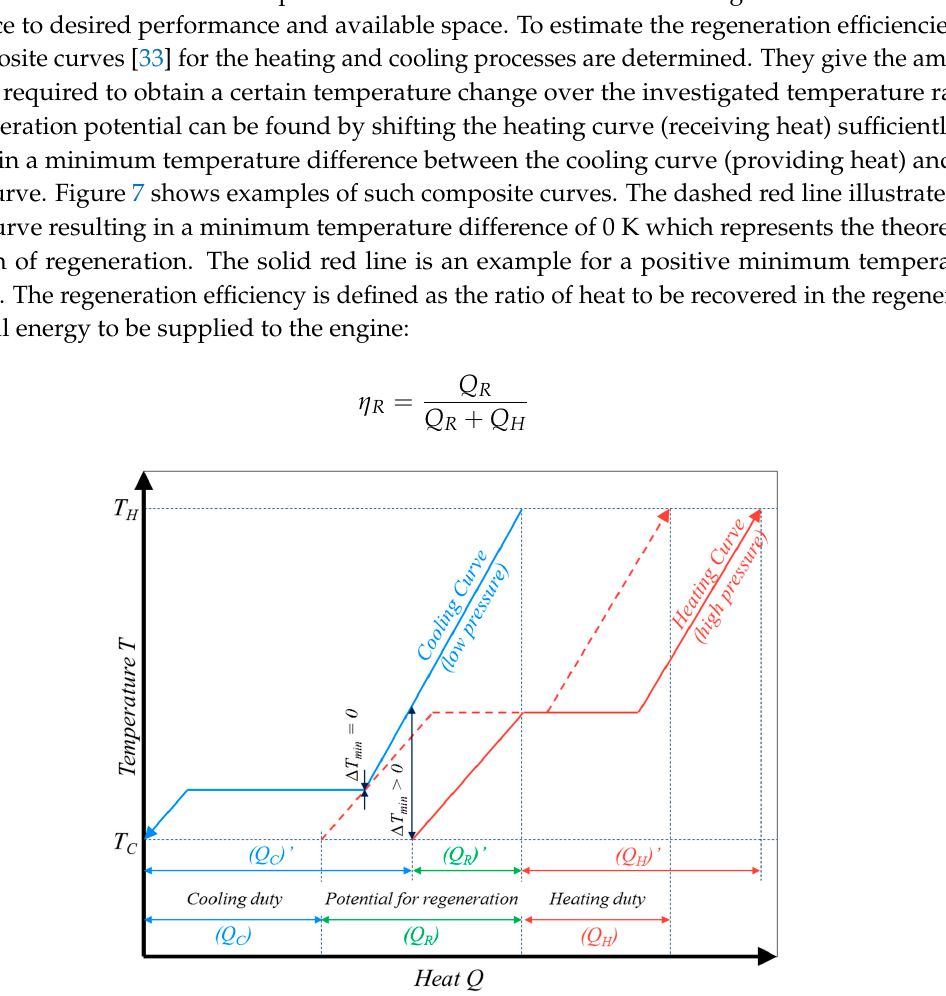
Figure 7. Example of composite curves during isobaric cooling and heating at different pressures; ( Q C )’, ( Q R )’ and ( Q H )’ are shown for the theoretical maximum of regeneration, whereas ( Q C ), ( Q R ) and ( Q H ) correspond to a real situation with the positive minimum temperature difference.